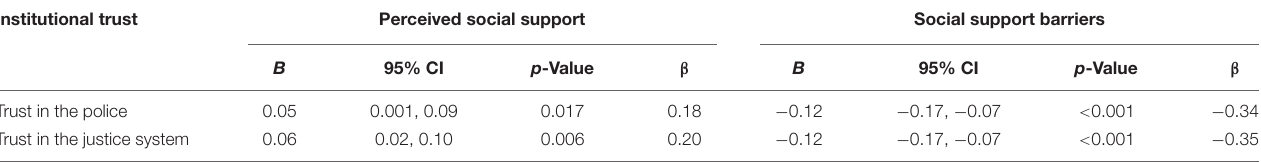
TABLE 4 | Associations between institutional trust and social support.